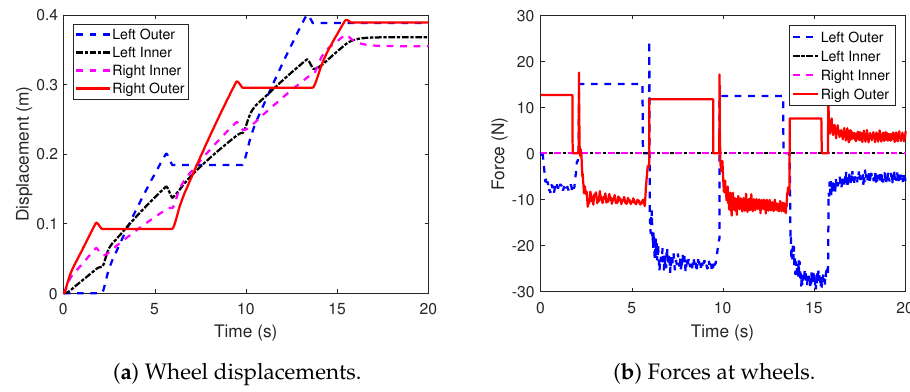
Figure 7. Rollo wheels displacement and applied forces during human-like locomotion.